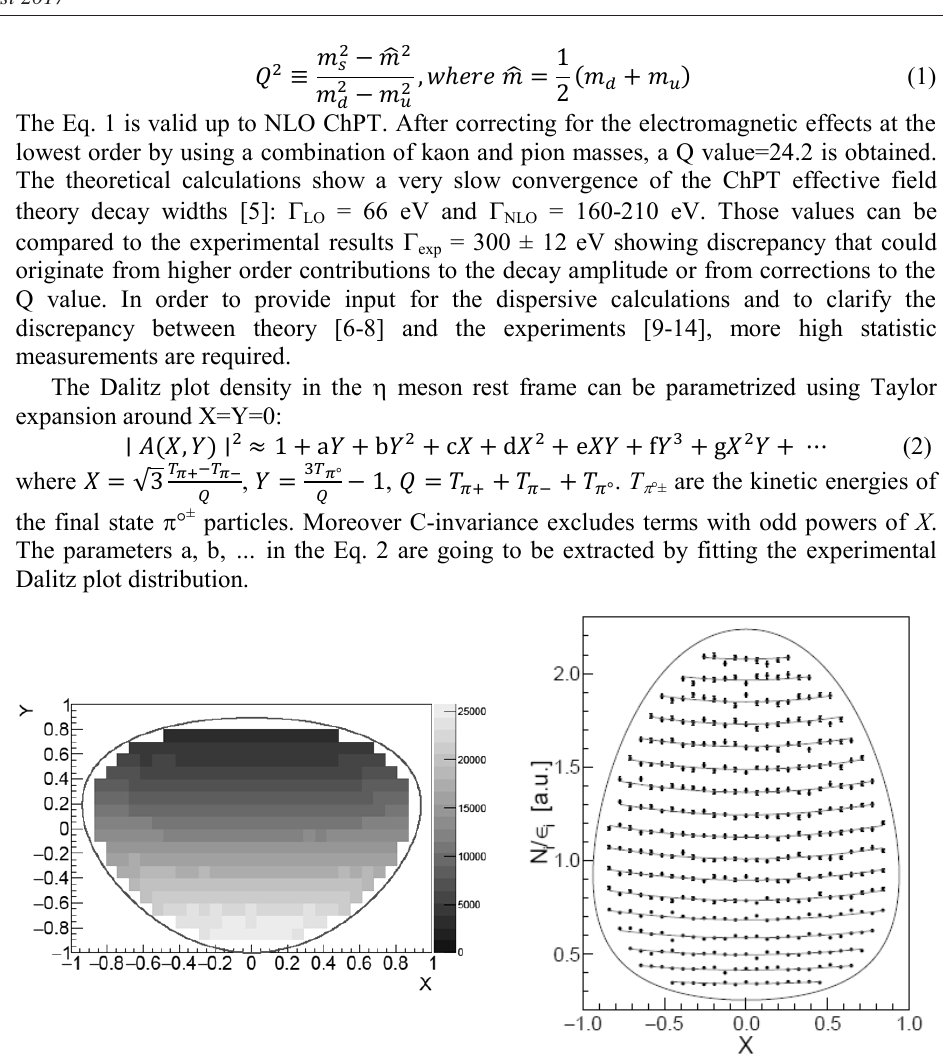
Fig. 1. Left: background-subtracted Dalitz plot of data. Right: acceptance corrected Dalitz plot data together with the result of the fit. Only statistical uncertainties are